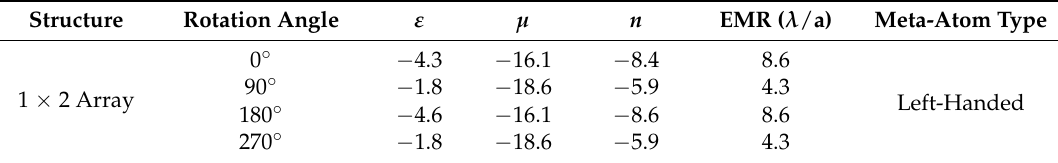
Table 3. Real values of ε , µ and n at 9.20